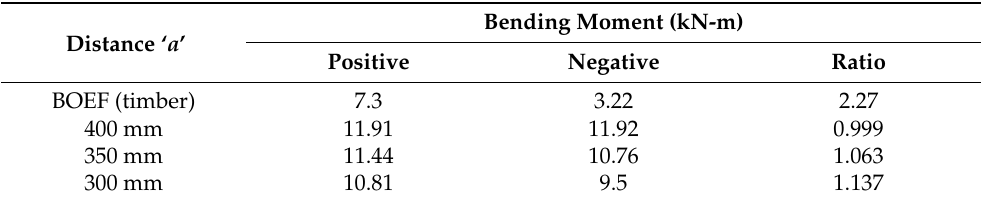
Table 2. Positive and negative bending moments of different “ a ” values.